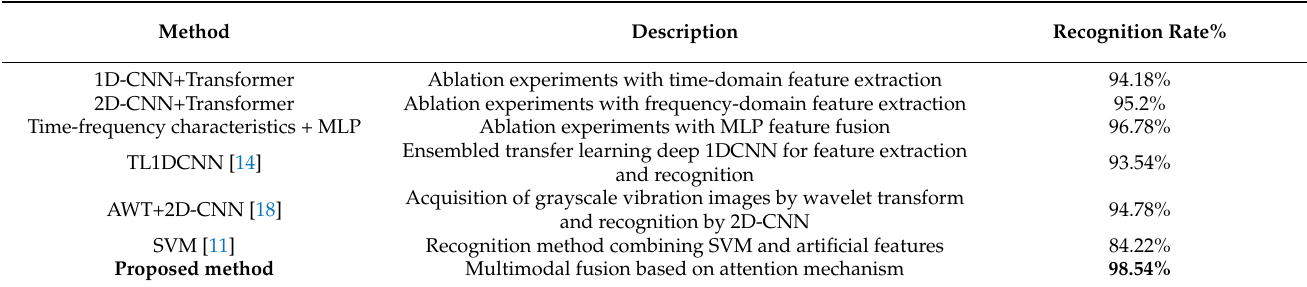
Table 3. Performance comparison of different